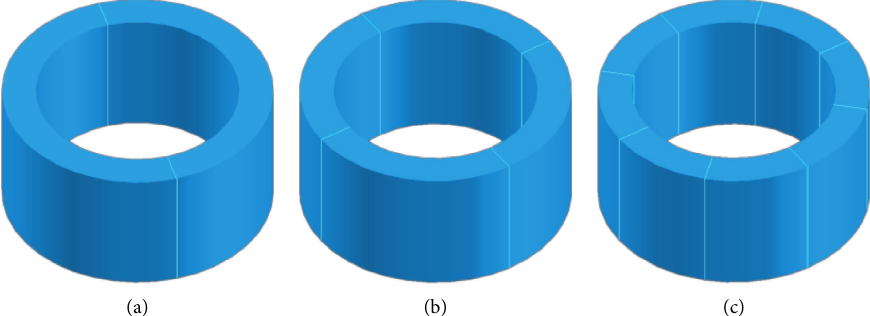
Figure 5: The valve seat is divided into identical shape tiles. (a) Two identical shape tile magnets. (b) Four identical shape tile magnets. (c) Eight identical shape tile